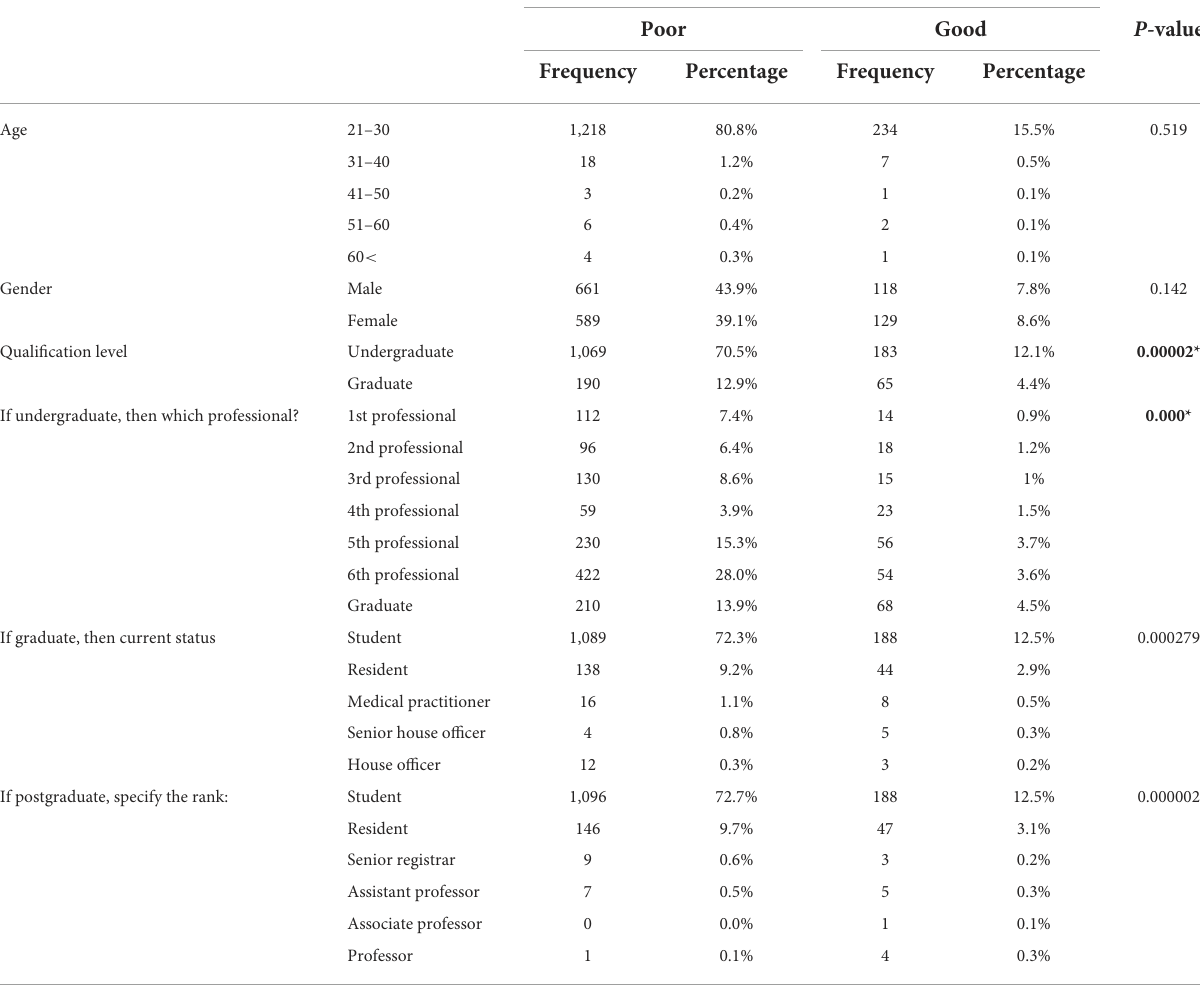
TABLE 4 Knowledge of AI based on gender, age, qualification level, professional, current status and rank of the